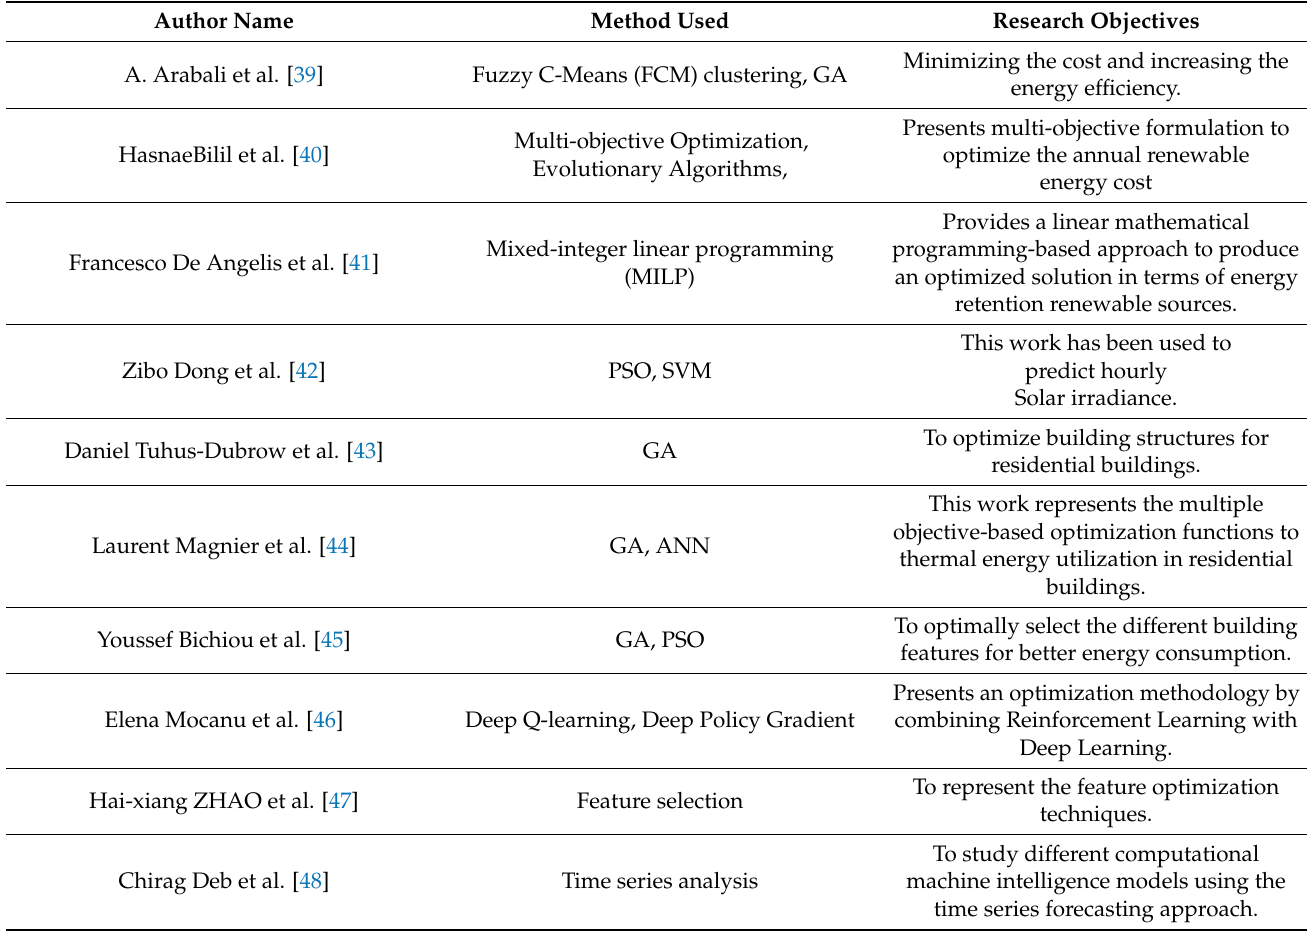
Table 3. Research articles based on optimization